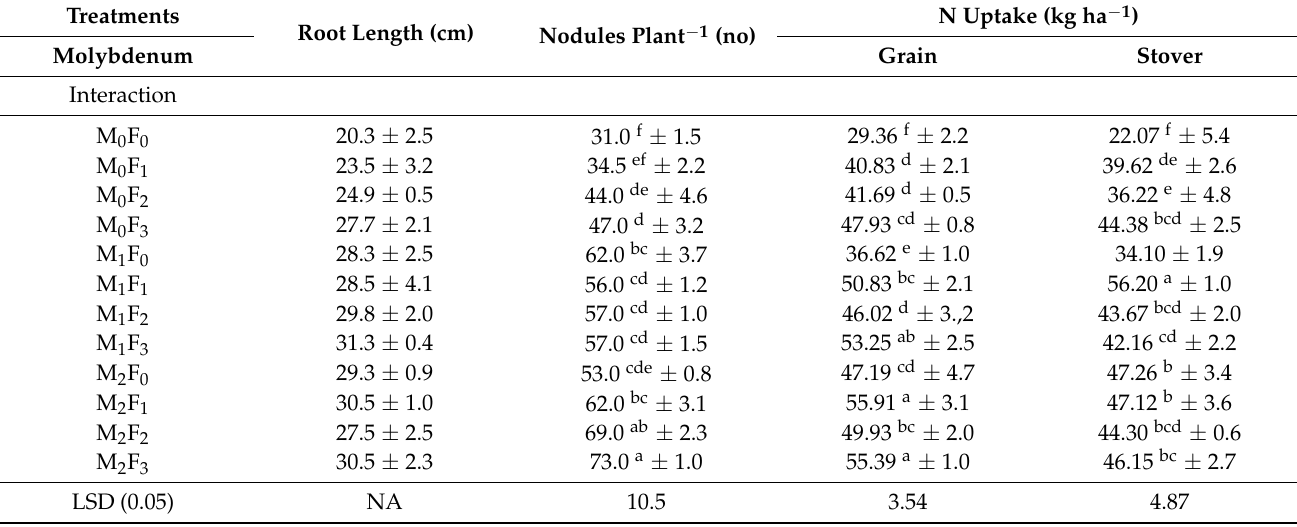
Table 5. Effect of the application of Zn, Fe and Mo molecules on root length, number of nodules and N concentration of